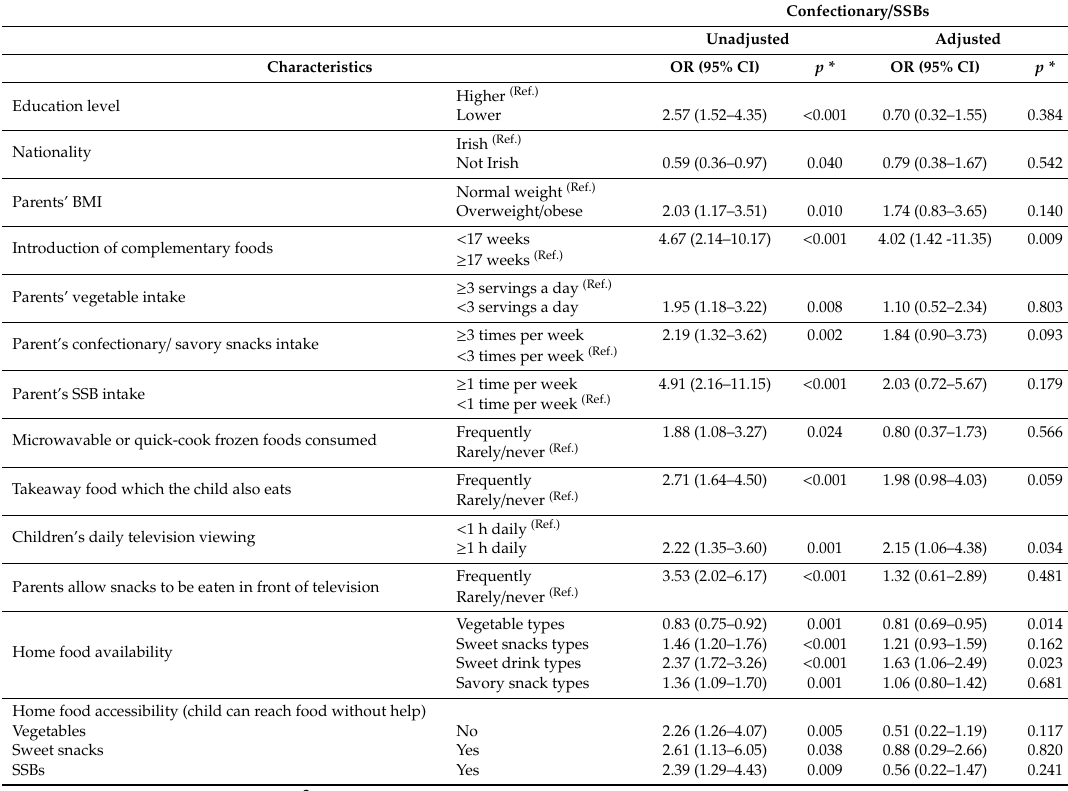
Table 6. Home environmental characteristics associated with children’s confectionary / SSB